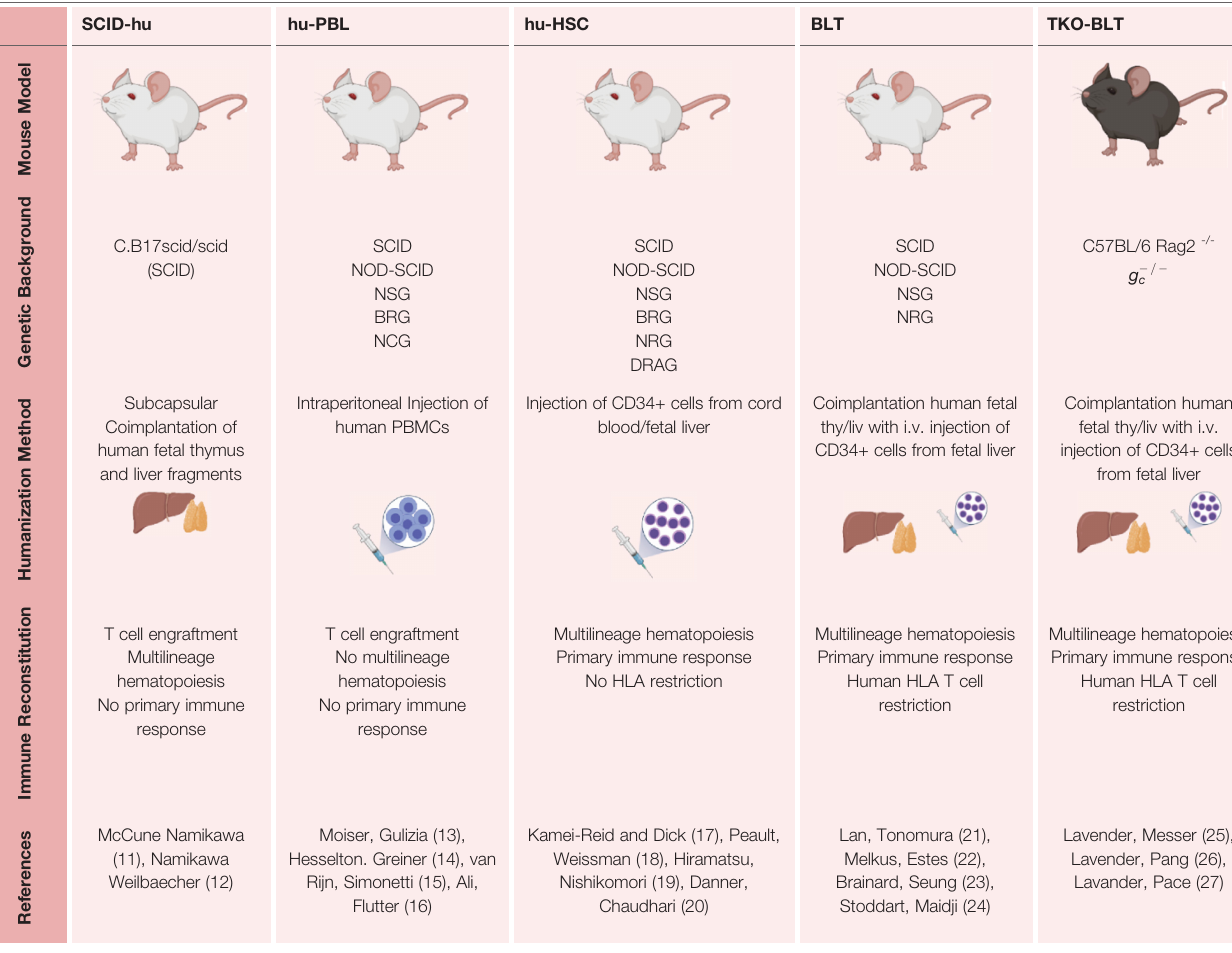
TABLE 1 | Summary of humanized mouse models and their tissue-based